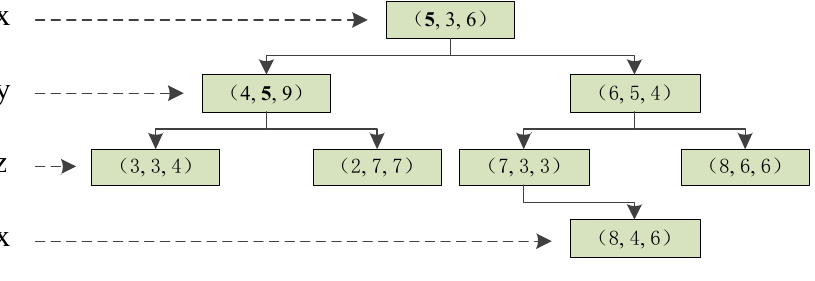
Figure 6. Create a kd-tree.